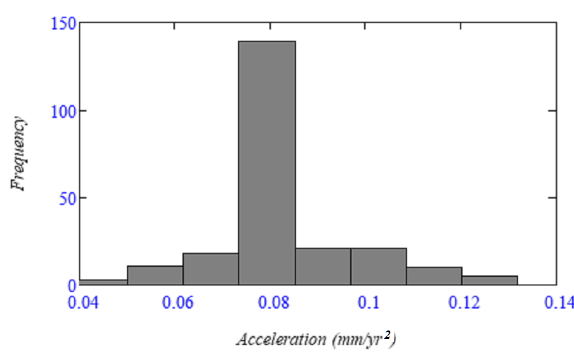
Fig. 9. Distribution of the alternative estimates for the contingent acceleration from the randomly manifested GMSL series for the current period of SA